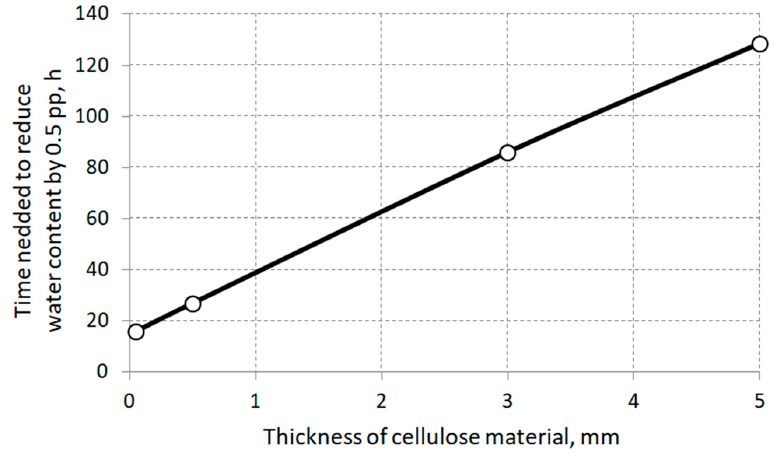
Figure 6. Time needed for the removal of 0.5 p.p. of water from samples in dependence on their thickness; drying temperature 70 °C; initial water content in cellulose materials was approx. 3%.